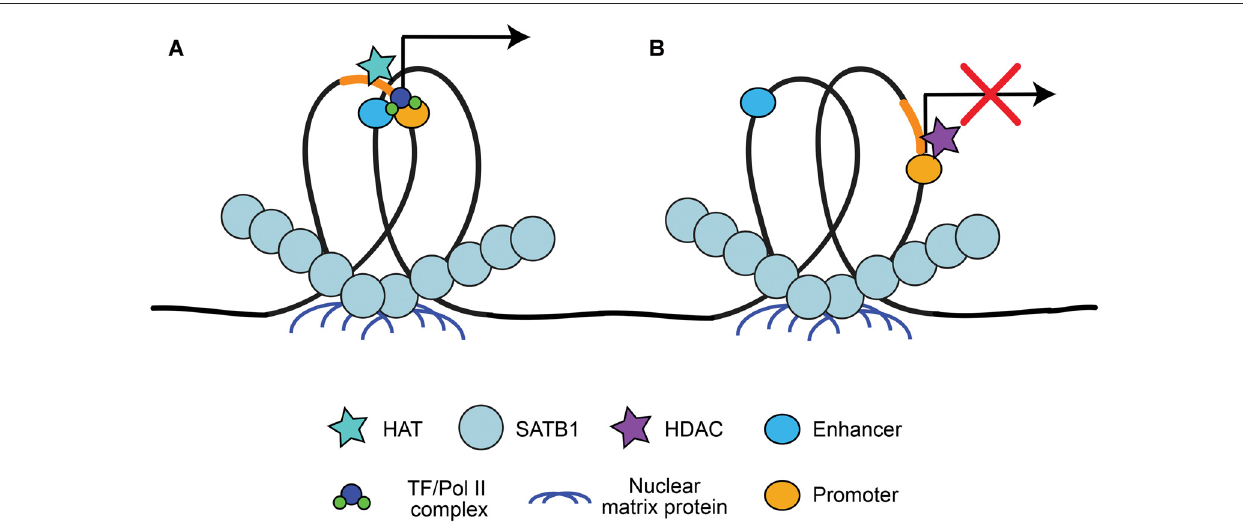
FIGURE 2 | Special AT-rich binding protein 1 (SATB1) recruitment to scaffolding/matrix attachment regions (S/MARs). SATB1 binds to DNA at regions that interact with the nuclear matrix, known as S/MARs. This results in locus specific chromatin looping of local or distant genes that can be accessed by chromatin organizers. (A) SATB1-mediated looping at S/MARs can bring distal enhancers close to gene promoters and recruit histone acetyltransferase (HATs) for acetylation, resulting in RNA Pol II/TF recruitment and transcriptional activation (Wen et al., 2005; Wang et al., 2009; Padmaja et al., 2010; Mirlekar et al., 2017). (B) SATB1 can also segregate enhancers from promoters and recruit histone deacetylases (HDACs), resulting in facultative or constitutive repression (Padmaja et al., 2010; Kohwi-Shigematsu et al., 2013; Mirlekar et al.,